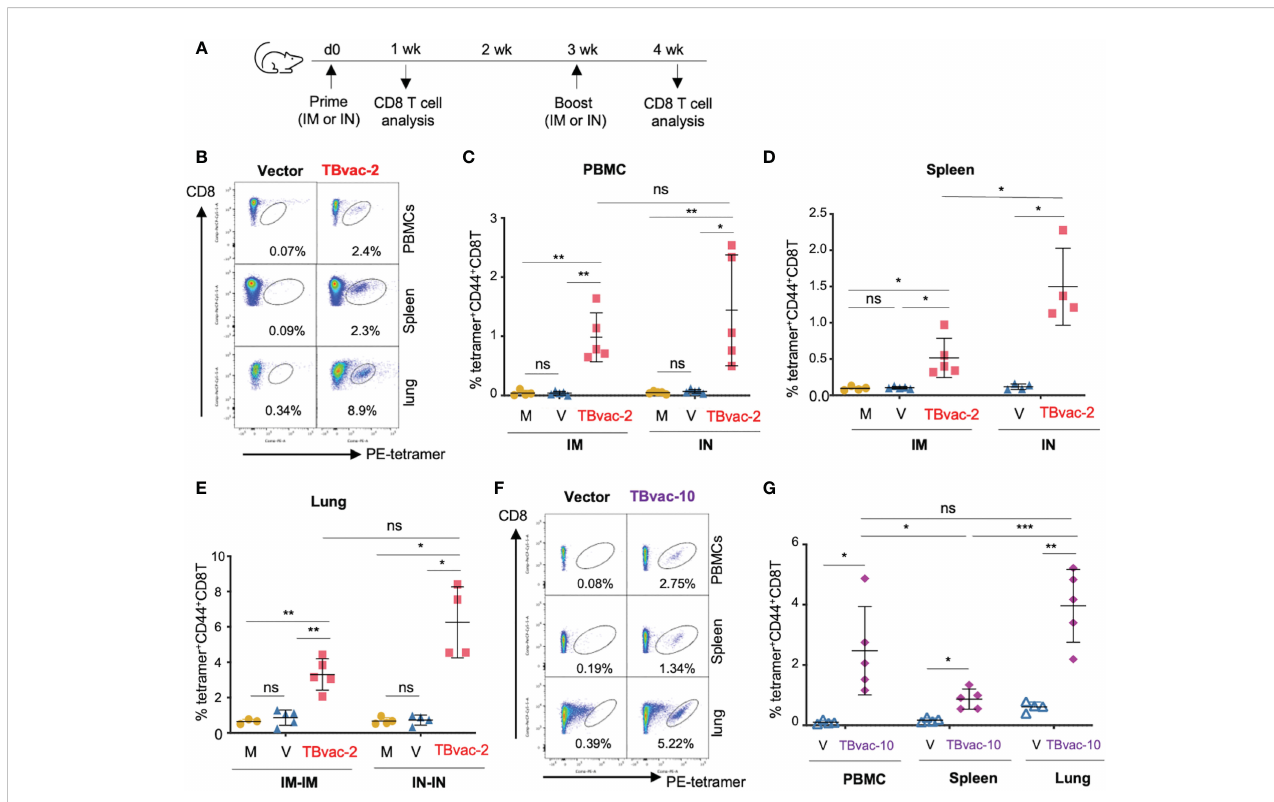
FIGURE 3 rP18tri-based TB vaccines induced strong antigen-speci fi c CD8 T cells through both IM and IN routes. (A) BL6 mice (N = 4-5) were immunized with PBS (M), rP18tri vector alone (V), or TBvac-2 through either IM or IN route. Lymphocytes from peripheral blood (PBMC), spleen, and lung were incubated with PE-labeled MHC-I EsxH tetramer, along with antibodies against surface markers (CD3, CD8, and CD44), and analyzed by fl ow cytometry. Representative fl ow cytometry plots of the tetramer-positive CD44 h CD8 T cells in peripheral blood (PBMC), spleens, and lungs from vector and TBvac-2-immunized mice are shown (B). The percentage of tetramer-positive CD44 h CD8T cells in PBMCs (C) and spleens (D) is shown for each group (M, V, and TBvac-2) at 7 dpp through IM or IN route. The percentage of tetramer-positive CD44 h CD8T cells in lungs (E) is shown for each group (M, V, and TBvac-2) at 7 days post-boost (dpb) through IM-IM or IN-IN route. A similar study was conducted to evaluate the TBvac-10-induced CD8T cells. BL6 mice (N=5) were immunized with rP18tri vector (V) or TBvac-10 through IM-IN prime-boost strategy. Representative fl ow cytometry plots (F) and the percentage (G) of tetramer-positive CD44 h CD8T cells at 7 dpb in PBMCs, spleens, and lungs from vector and TBvac-10-immunized mice are shown. Statistical analysis was conducted with unpaired t-test. ***p < 0.001; **p < 0.01; *p < 0.05; ns, not signi fi